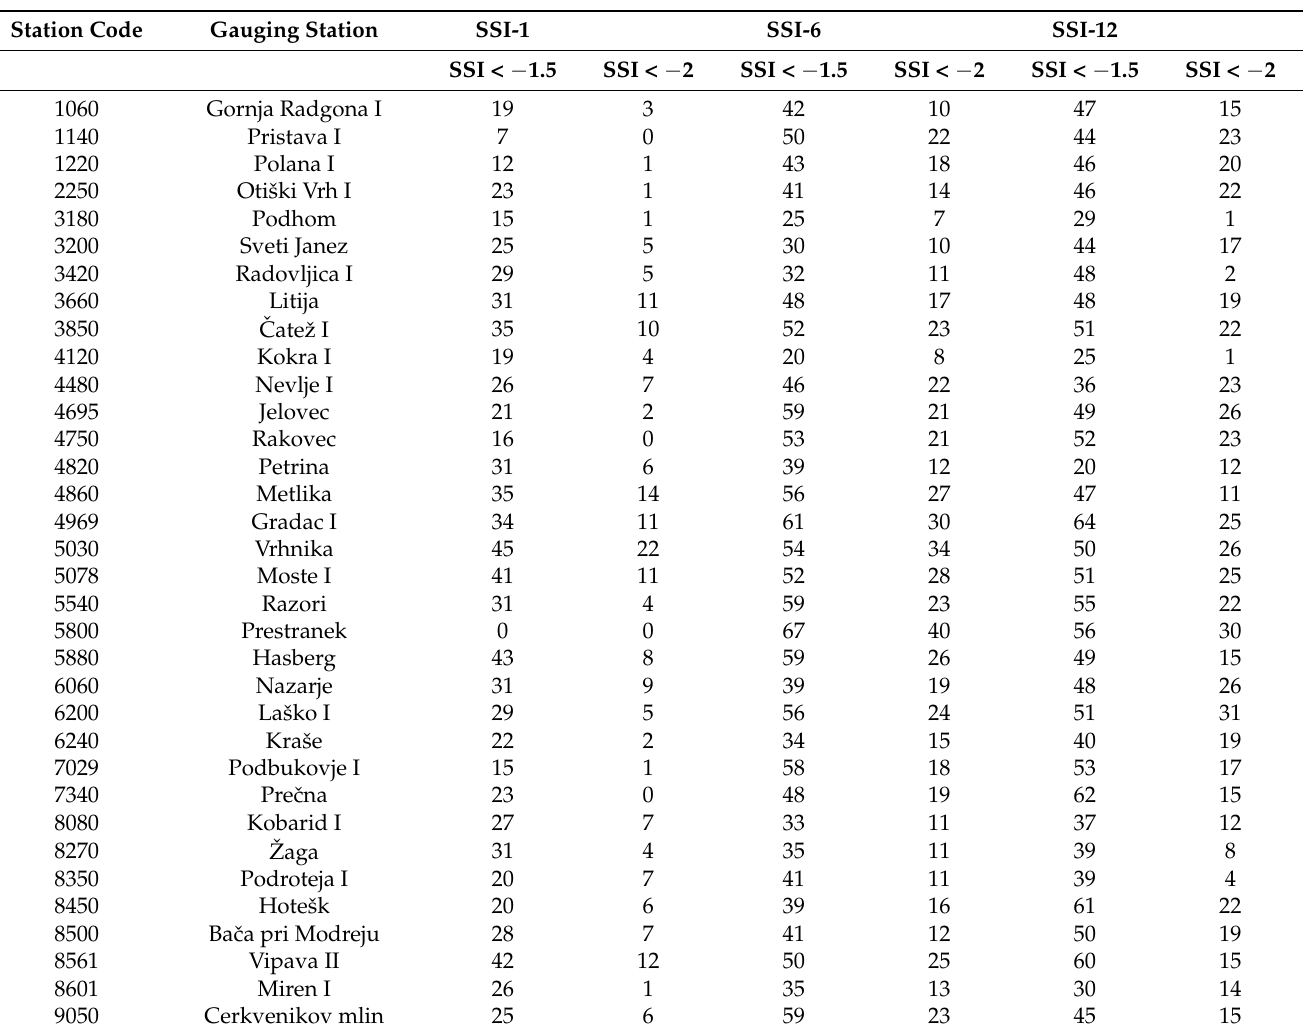
Table 3. The total number of severe and extreme drought events at the considered gauging